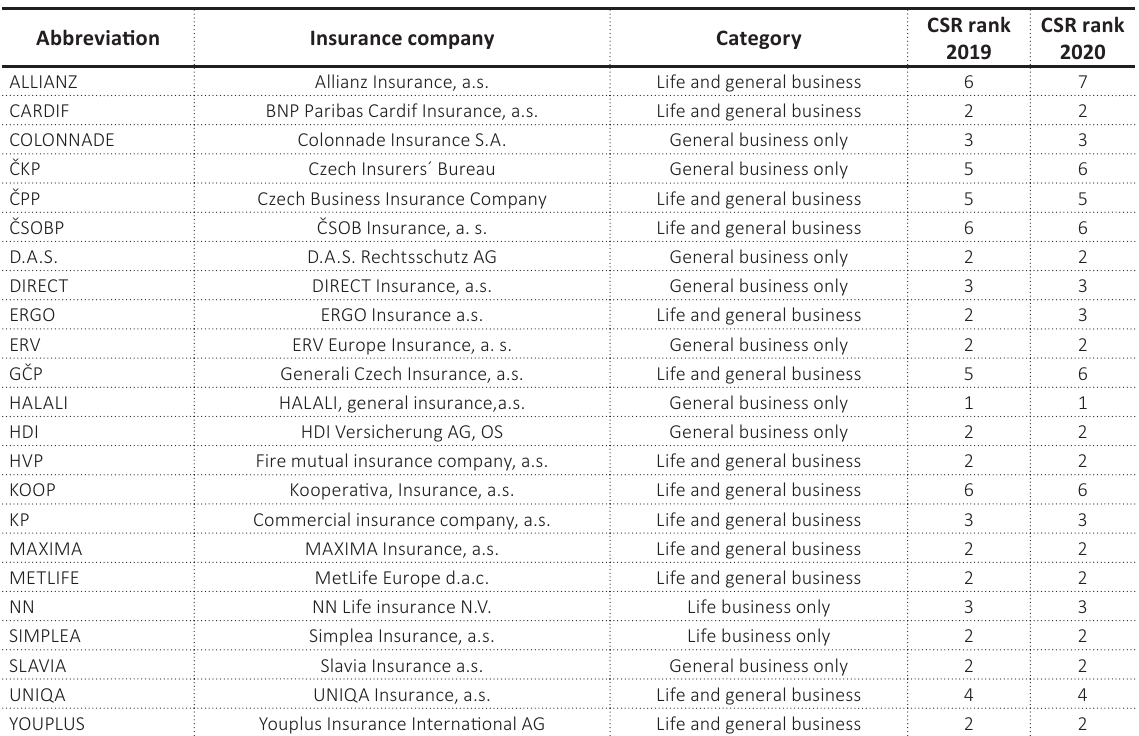
Table 1. Evaluation of the insurance